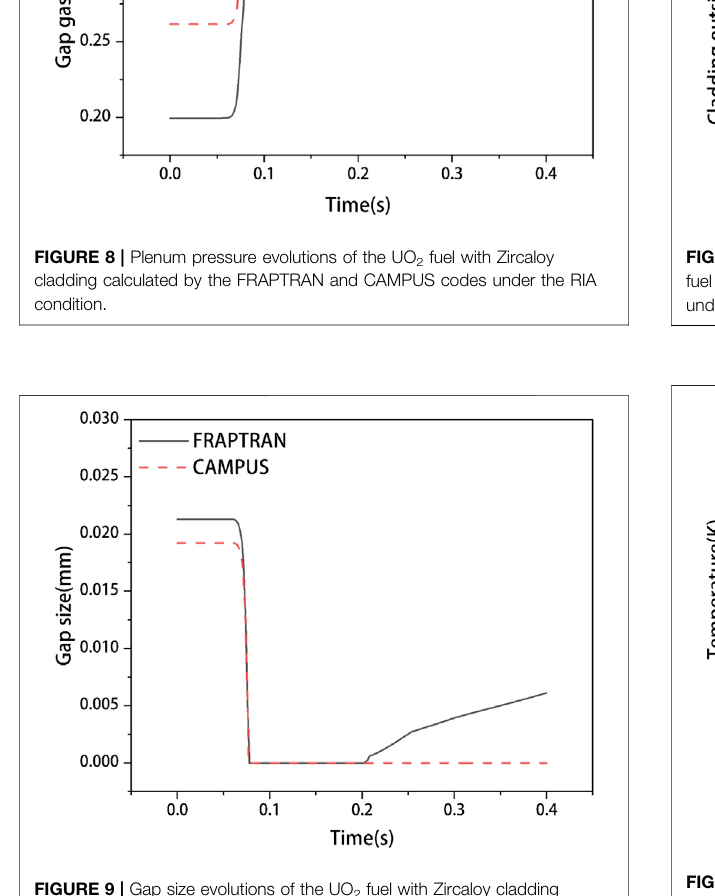
FIGURE 9 | Gap size evolutions of the UO 2 fuel with Zircaloy cladding calculated by the FRAPTRAN and CAMPUS codes under the RIA condition.